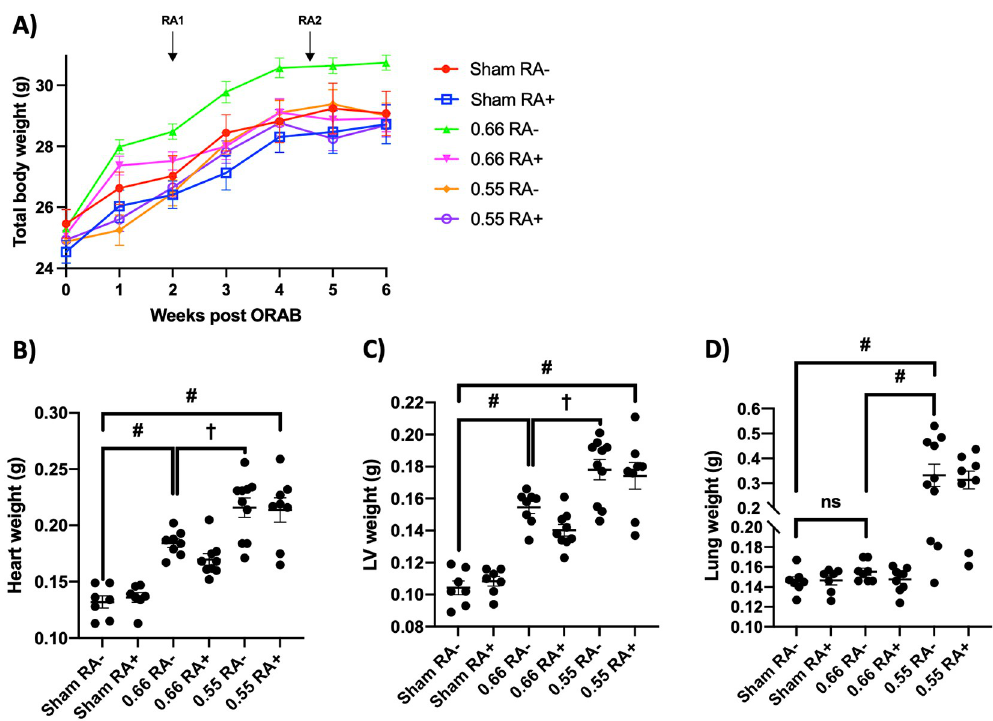
Fig 3. Temporal body weight alterations and organ weights. Panel A : Development of mice body weight within the various intervention groups throughout the timespan of the study (n = 7, 7, 8, 9, 10, 8 for sham RA-, sham RA+, ORAB 0.66 RA-, ORAB 0.66 RA+, ORAB 0.55 RA- and ORAB 0.55 RA+, respectively). Day 0 represents data before ORAB surgery, arthritis was induced at 2 weeks (RA1). At day 18 after RA induction, arthritis was re-established with an additional injection with mBSA (RA2). Data is mean ± SEM. Panel B-D : Total heart weight, left ventricular weight, and lung wet weight at the time of euthanization (n = 7, 7, 8, 9, 10, 8 for sham RA-, sham RA+, ORAB 0.66 RA-, ORAB 0.66 RA+, ORAB 0.55 RA- and ORAB 0.55 RA+, respectively). Data is presented as scatter plots with mean ± SEM. Statistical significance was calculated using one- way ANOVA with Bonferroni’s multiple comparisons test. ns = non-significant, � P < 0.05, † P < 0.01; ‡ P < 0.001, # P < 0.0001. ORAB, o-ring aortic banding; mBSA, methylated bovine serum albumin.